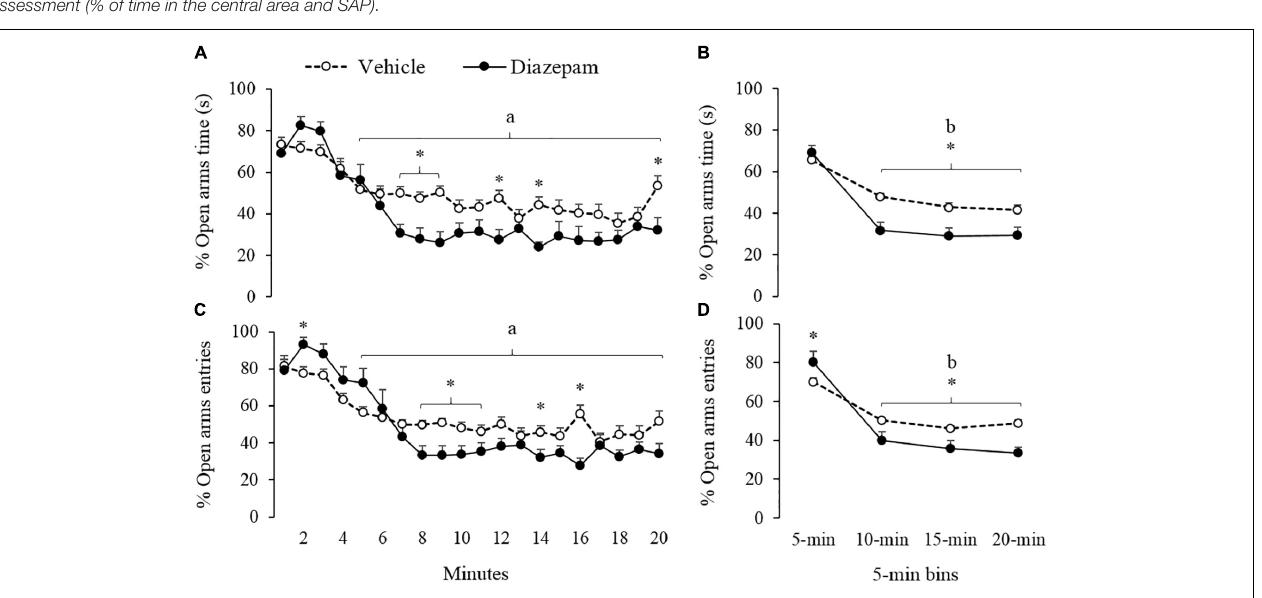
Factor 1 Factor 1 Factor 2 Factor 3 Escape-related Anxiety-related Approach to the Risk-assessment behaviors behaviors closed arms behaviors